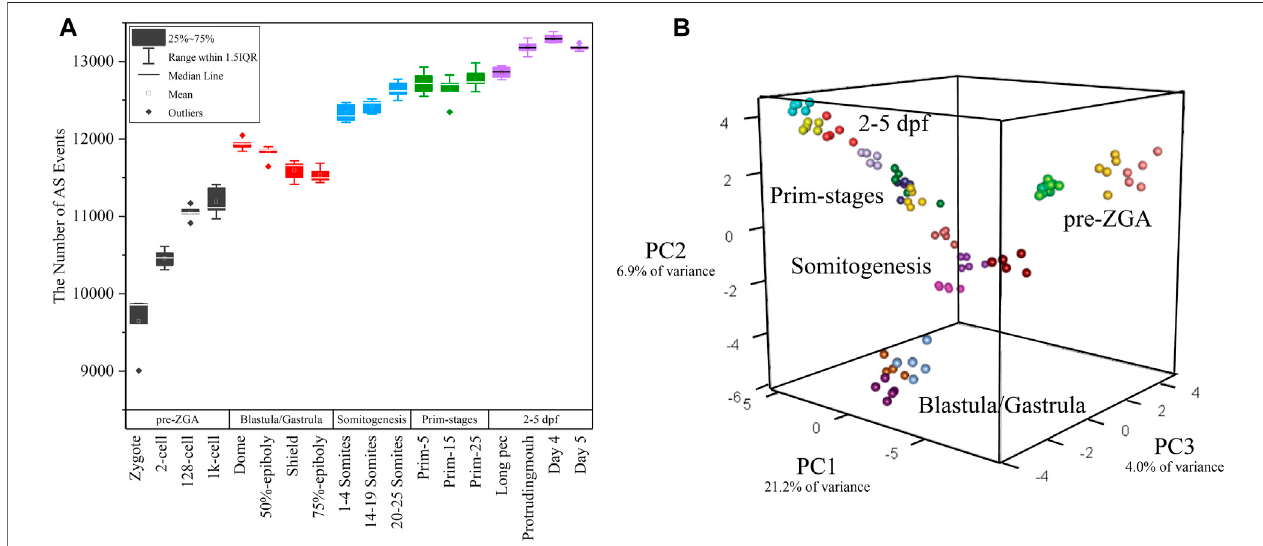
FIGURE 3 | The distribution of alternative splicing events in 18 developmental stages. (A) The boxplot of detected alternative splicing events at 18 developmental stages. (B) 3D plot of PCA during embryogenesis stages. The samples in different stages were denoted with different colors.